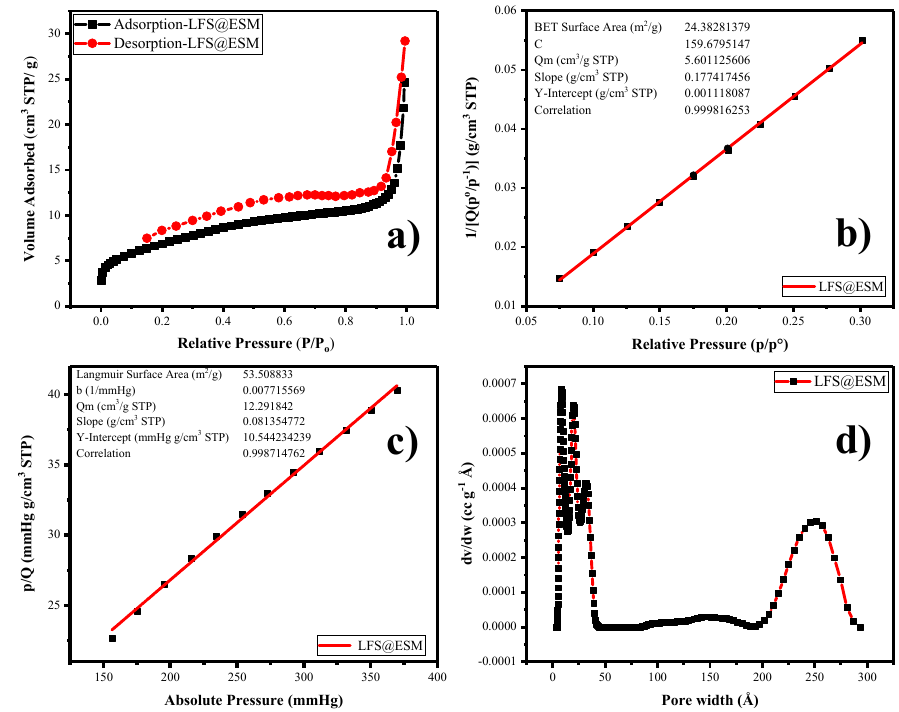
Figure 3. ( a ) Nitrogen adsorption-desorption, ( b ) Brunauer–Emmett–Teller plot (BET), ( c ) Langmuir surface area, ( d ) pore size distribution of LFS@ESM.